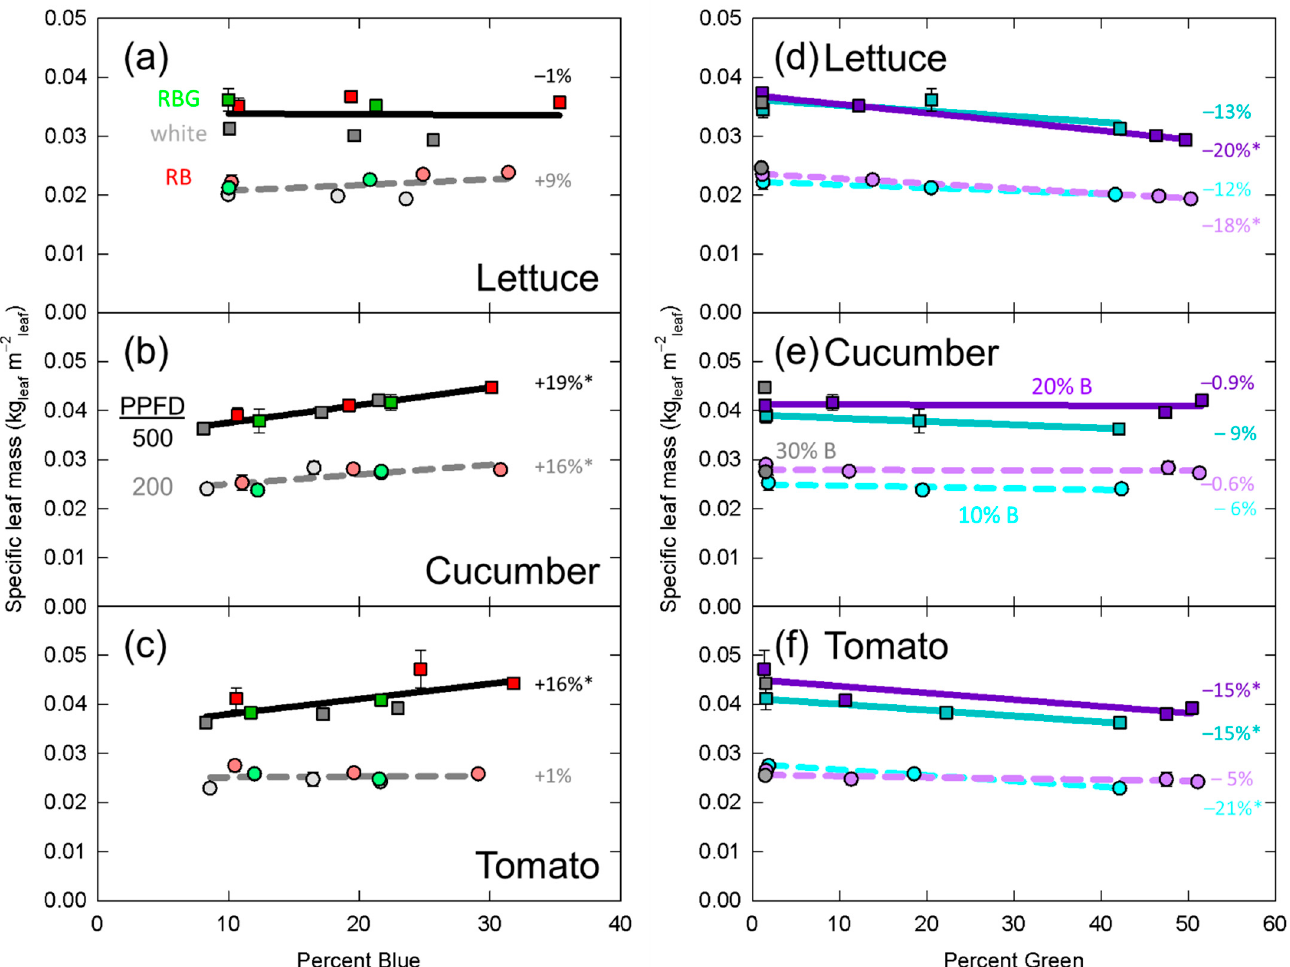
Figure 5. Effect of percent blue on specific leaf mass in ( a ) lettuce, ( b ) cucumber, and ( c ) tomato; and effect of percent green on specific leaf mass in ( d ) lettuce, ( e ) cucumber, and ( f ) tomato. * represents a significant effect of percent blue or percent green at the p < 0.05 level. See Figure 3 for the meaning of specific labels. Error bars represent normalized standard error of n = 3 replicates.